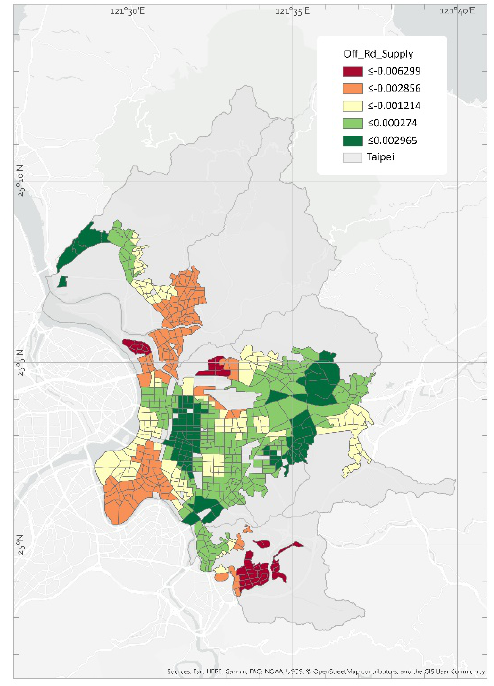
Figure 3. Coefficient of Off-road Parking Space